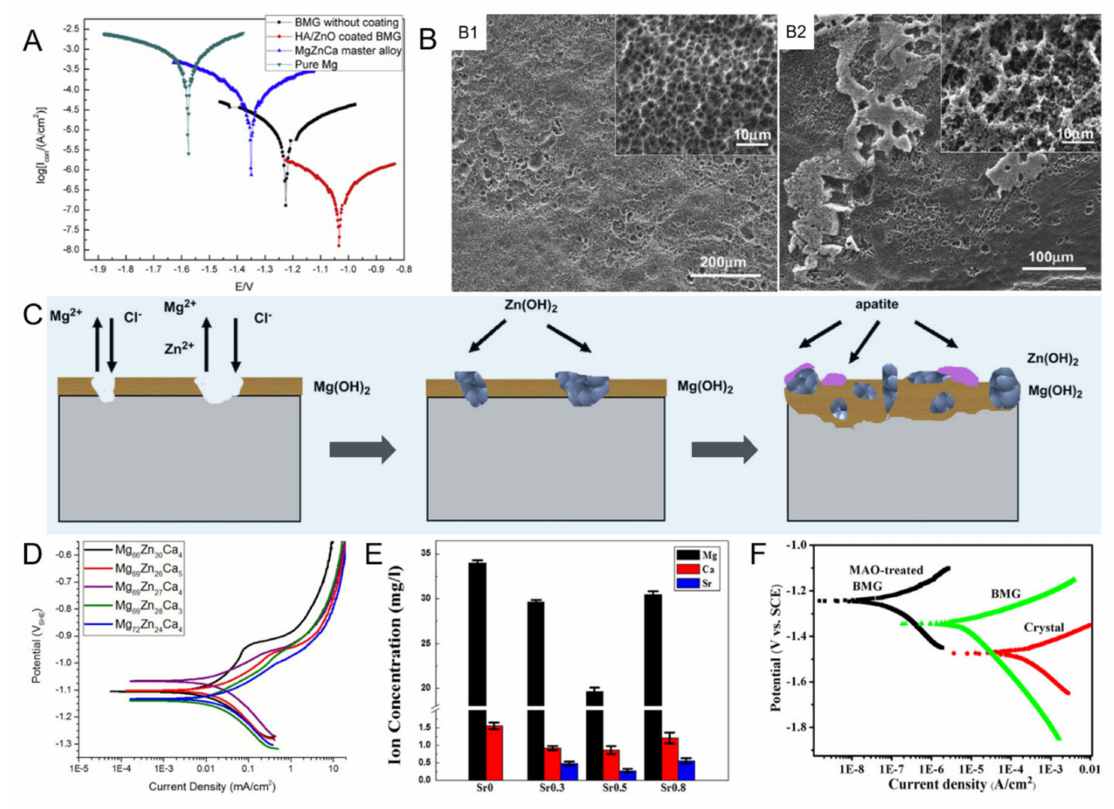
Figure 3. Biocorrosion of Mg–Zn–Ca-based MGs. ( A ) Polarization curves of Mg, Mg 68 Zn 28 Ca 4 MG, crystal Mg 68 Zn 28 Ca 4 alloy, and HA-coated MG, reproduced with permission from [61]. ( B ) SEM images of the surface morphologies of ( B1 ) Mg 66 Zn 30 Ca 4 and ( B2 ) Mg 70 Zn 25 Ca 5 MGs after immersing in CrO 3 solution for 10 min, reproduced with permission from [82]. ( C ) The sketch map for the evolution of corrosion process of Mg–Zn–Ca MG immersed in SBF, reproduced with permission from [82]. ( D ) Representative polarisation curves of Mg rich MGs in MEM at 37 ◦ C and 5% CO 2 , reproduced with permission from [102]. ( E ) Metallic ion concentrations of the solution after the 3-days immersion test in PBS at 310 K, reproduced with permission from [66]. ( F ) Polarization curves in SBF of Mg 65.2 Zn 28.8 Ca 6 crystalline alloy, Mg 65.2 Zn 28.8 Ca 6 MG, and MAO-treated Mg 65.2 Zn 28.8 Ca 6 MG, reproduced with permission from